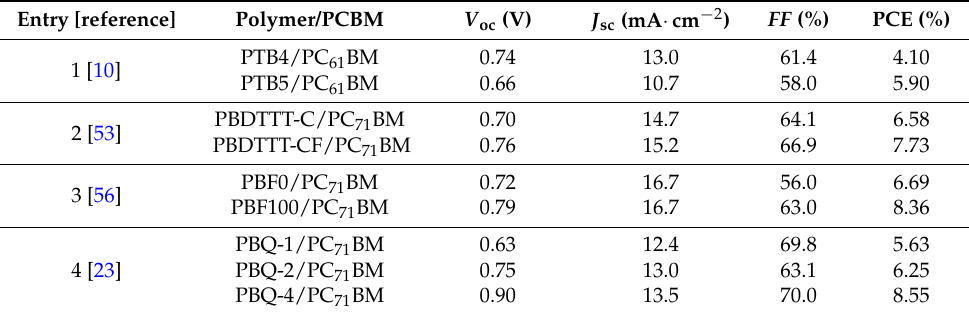
Table 3. Characteristic properties of polymer solar cells.